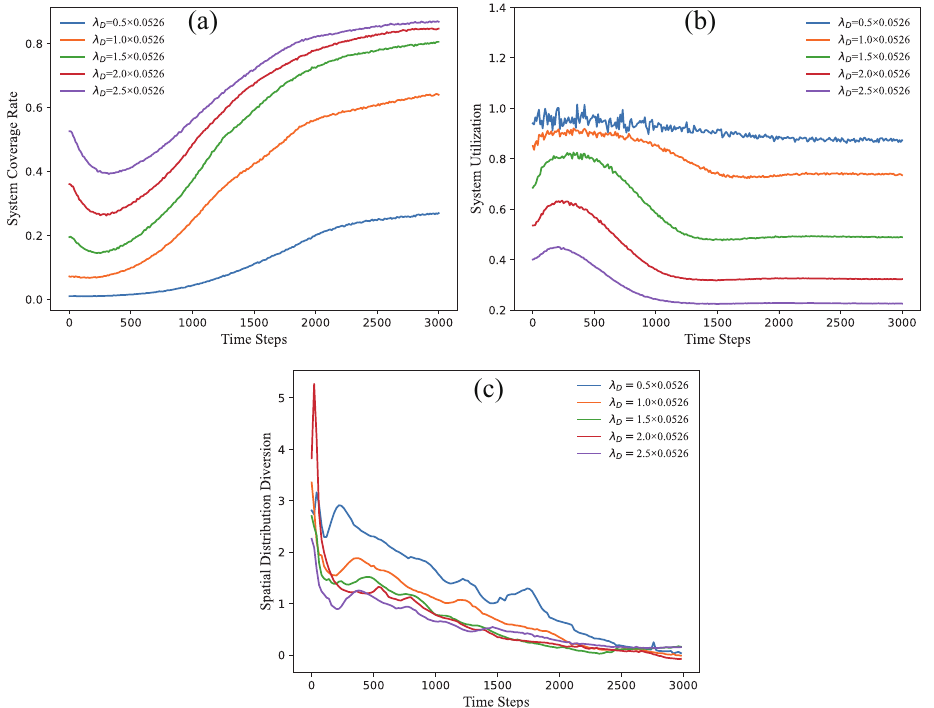
Figure 7. ( a ) The change of system coverage rate, ( b ) the change of system utilization rate, and ( c ) the variation of the spatial distribution diversion depending on different λ D as a function of the calculation time